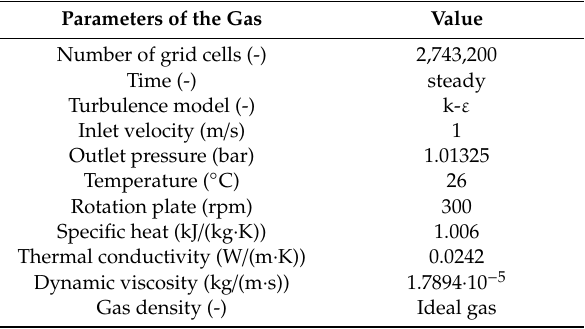
Table 2. CFD simulation parameters.